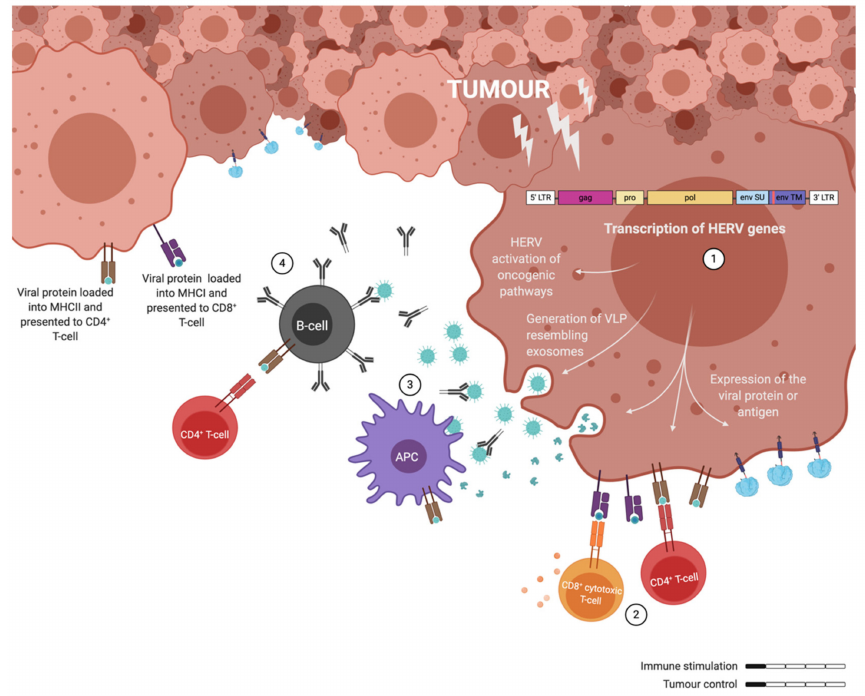
Figure 3. Illustration of the immune responses elicited by human endogenous retrovirus (HERV) expressing tumour cells. (1) ERV genes are transcribed in cancer cells and not only contribute to oncogenic pathways, but also to the release of exosomes (VLPs) and the presentation of antigens on the surface of cancer cells. (2) CD4 + and CD8 + T-cells can recognise ERV antigens, but they fail to get e ffi ciently activated. (3) Similarly, antigen presenting cells (APCs) process the ERV particles and fail to elicit a potent T-cell response upon presentation. (4) Some activated B-cells can generate ERV specific antibodies. Overall, cancer associated retroviruses elicit non-protective immune responses through weak immune